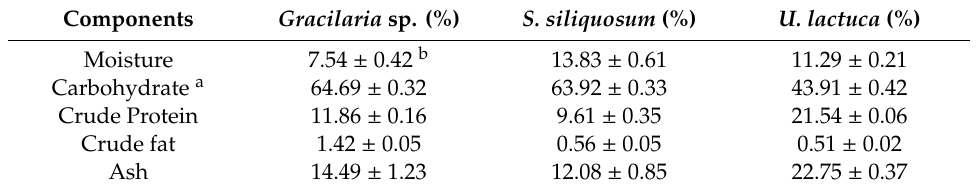
Table 1. Proximate composition (%) of driedred seaweed Gracilaria sp., brown seaweed S. siliquosum , and green seaweed U. lactuca .